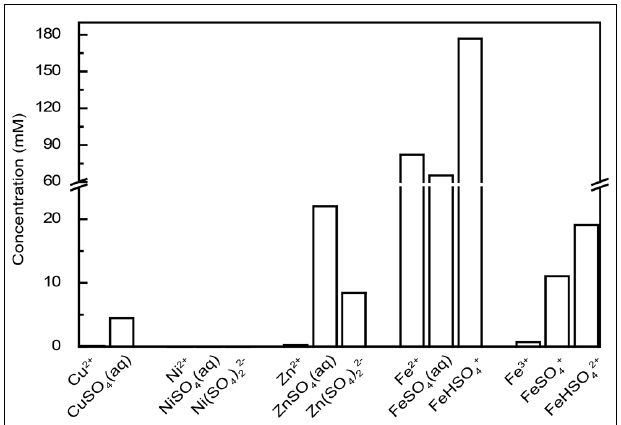
FIGURE 1 |The fraction of total free metal ion (Fi) for each of the metals. The amount of free metal ion (Fi) of Zn 2 + (solid line), Cu 2 + (long dashes), and Ni 2 + (short dashes) denoted as a fraction (100% free ion defined as 1.0) of total metal ion present in each of the species.The metal concentrations are calculated for systems with 200 mM of the respective metals, 285 mM SO 42 − , and 50 mM Fe 2 + .The calculations are made using the computer codeWinSGW (Karlsson and Lindgren, 2006) based on the speciation code Solgaswater (Eriksson, 1979). Equilibrium constants are collected from the equilibrium database Hydra/Medusa (Puigdomenech, 2004).